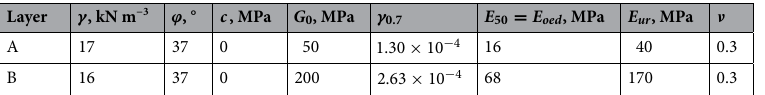
Table 1. Parameters for layers modelled with Hardening Soil Small Strain Model.